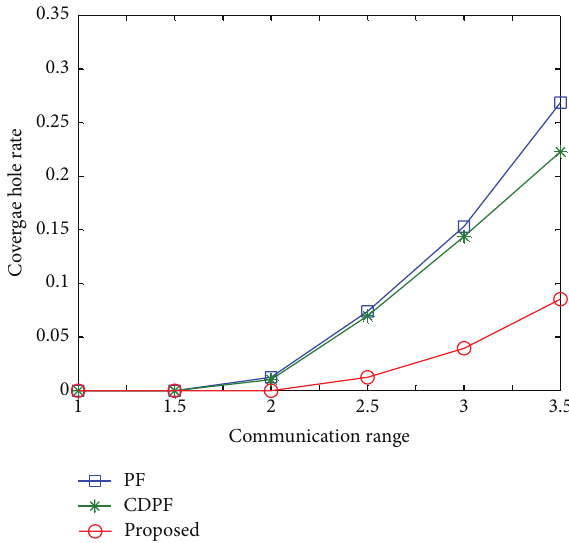
Figure 3: Coverage rate versus communication range (𝑟 𝑐 /𝑟 𝑠 ) .